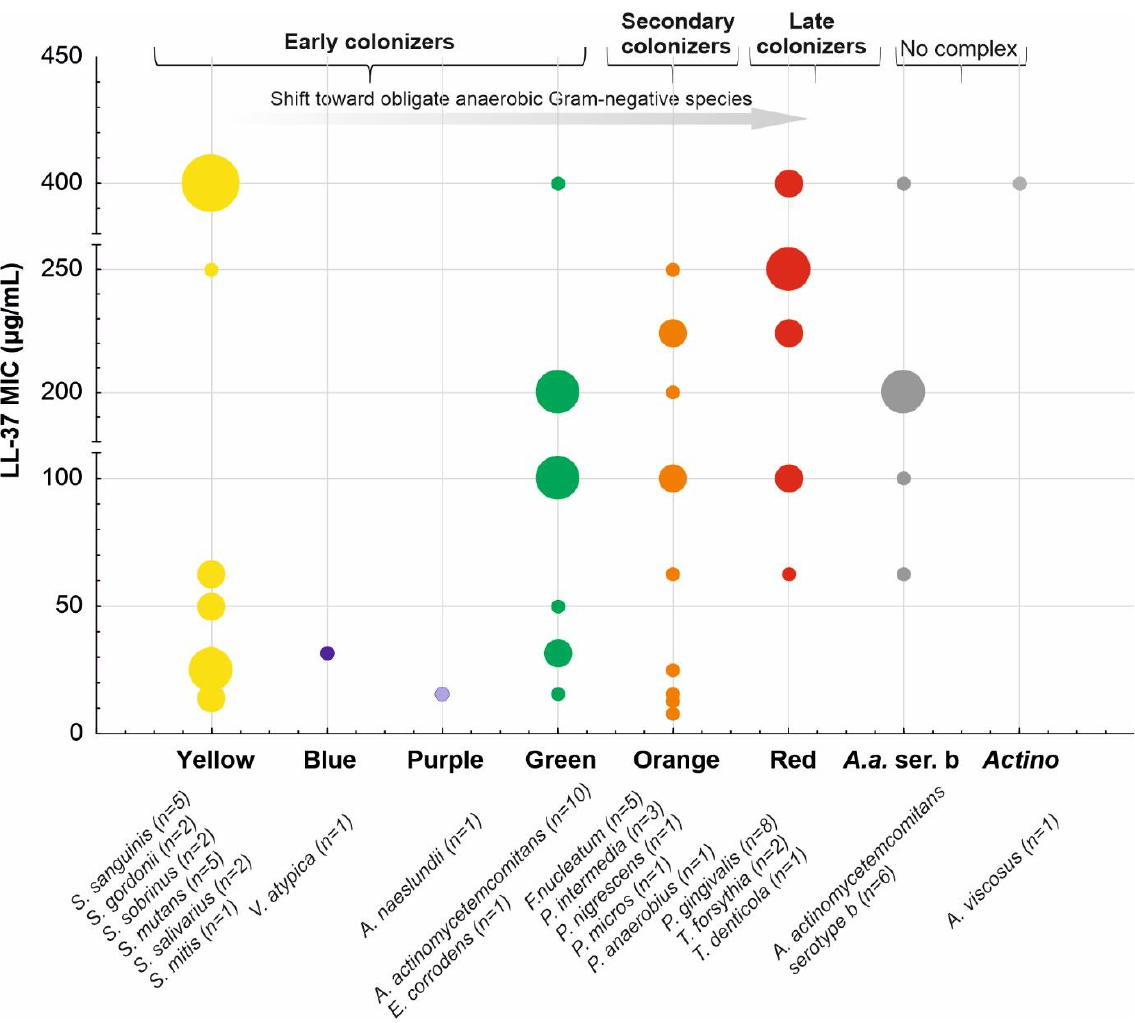
Figure 7. Susceptibility of selected bacteria representing the periodontal complexes (yellow, blue, purple, green, orange, and not-belonging-to-any-complex A. actinomycetemcomitans serotype b and A. viscosus ) to LL-37 (MIC values, µ g/mL) based on the references [55,57–60]; the repeated strains in various studies were analyzed individually, and for MICs expressed as “>” or not recorded “ ≤ ,” for example, >100 or ≤100, the higher dilution value, i.e., 200, was used.